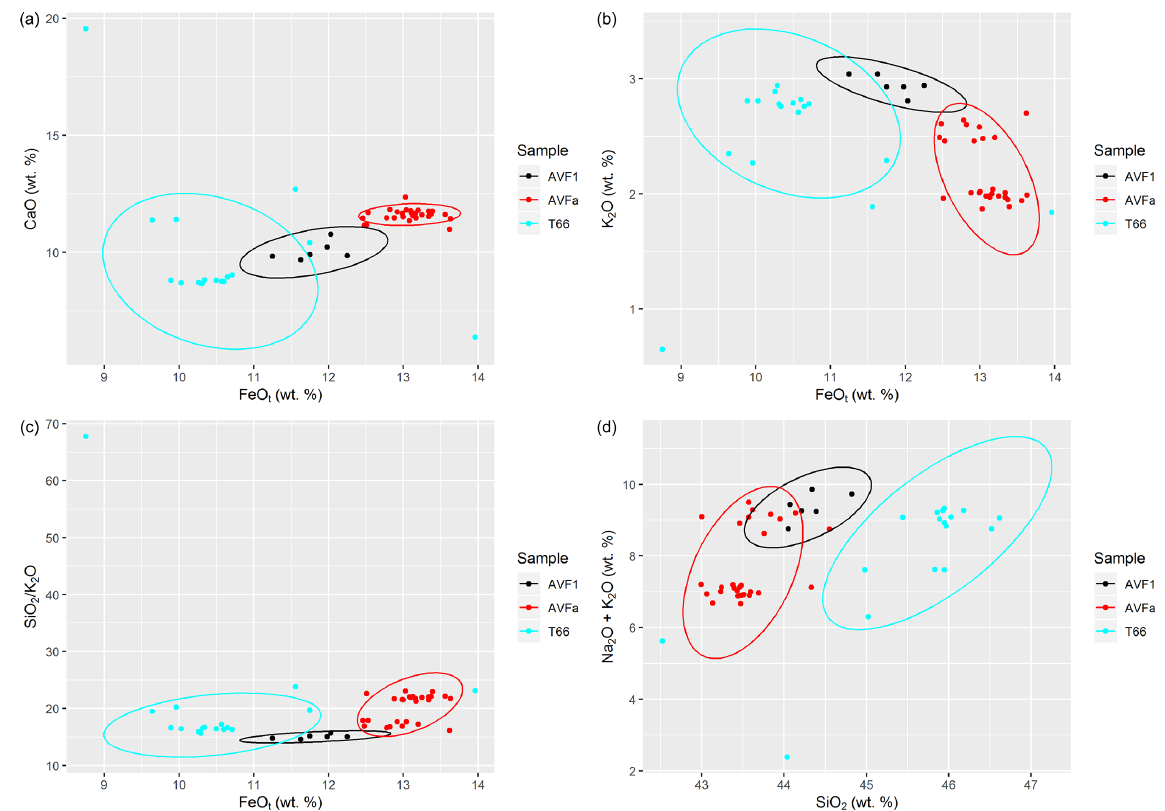
Figure A5. Comparison of sample T66 to AVF1 (tephra layer in Orakei 2007 core: Hopkins et al., 2015; Molloy et al., 2009; correlated to Domain: Hopkins et al., 2017) and AVFa (tephra layer from Glover Park core correlated to the Orakei volcanic centre; Hopkins et al., 2015, 2017). Note that T66 overlaps with neither layer and thus is considered an eruption not previously found in the AVF maar cores. Ellipses follow a multivariate t distribution (Fox and Weisberg,